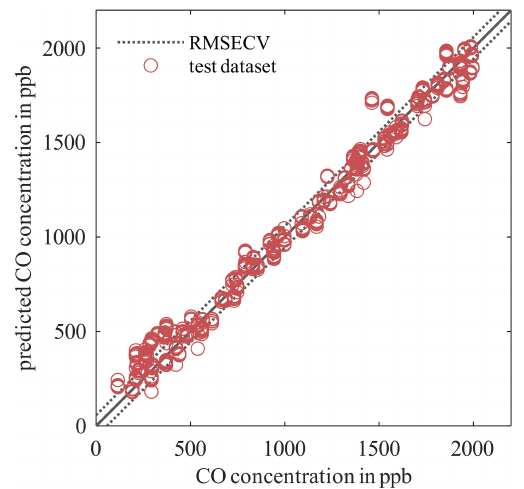
Figure 3. PLSR model for the AS-MLV-P2 for quantification of carbon monoxide (CO). The model was calculated and 10-fold cross-validated from a reduced dataset with 198 randomized gas mixtures (measurements 8 and 9). The model was tested with 99 randomized gas exposures containing seven cycles each (measure- ment 10, open circles).